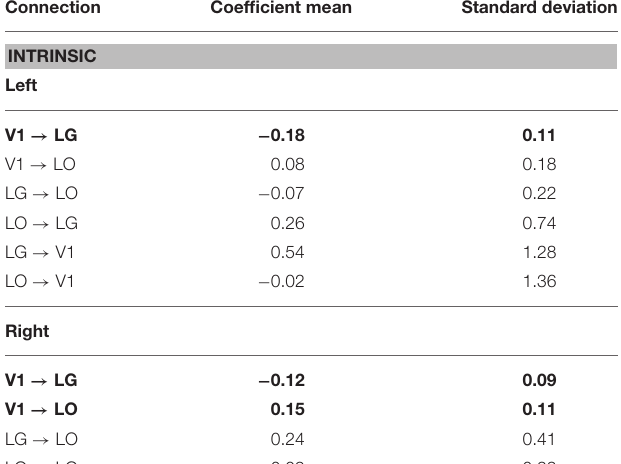
TABLE 4 | Coefficient means and standard deviation for the modulations of the connections in the winning model. Connection Coefficient mean Standard deviation